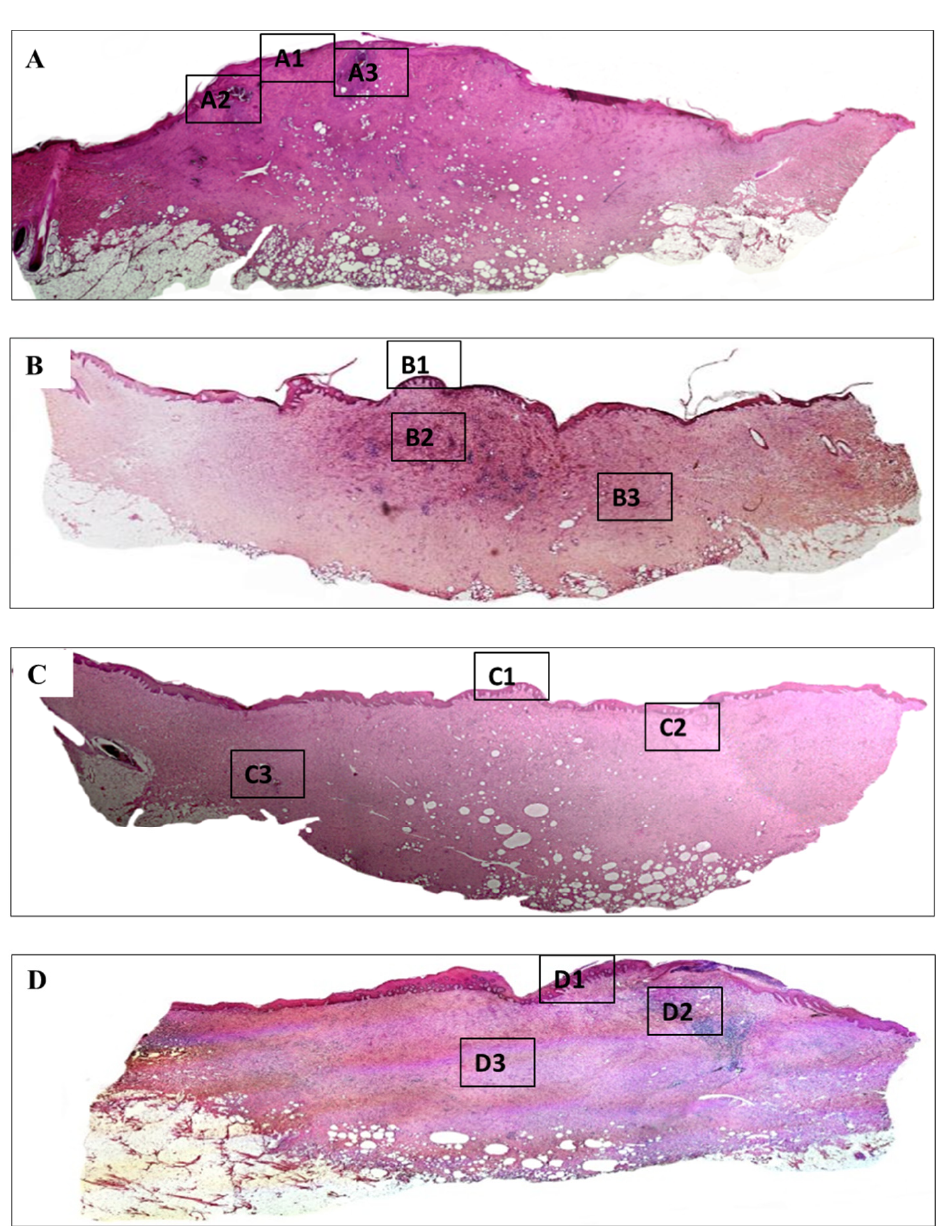
Figure 8. H&E stained sections of wounds treated with ( A ) normal gauze, ( B ) Aquacel, ( C ) UrgoTul, and ( D ) PCLGelAg membranes. The tissue sections are magnified at ( A1 – D1 ) the new epidermis, ( A2 , A3 , B2 , B3 , C2 , C3 , D2 , D3 ) inflammatory areas and some newly generated